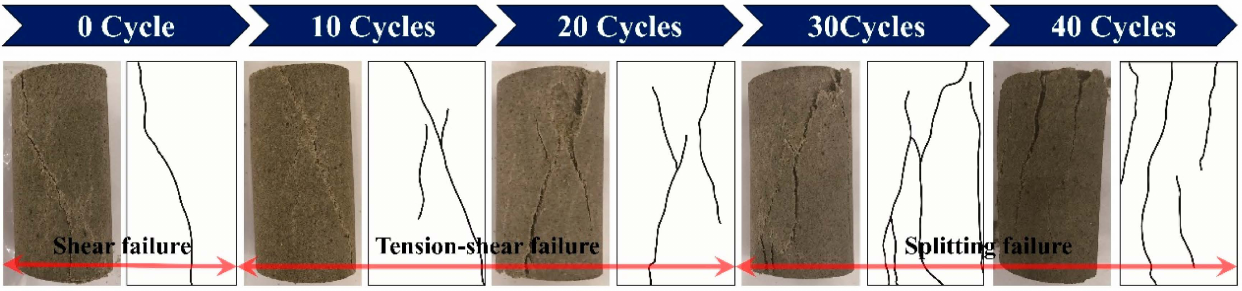
Figure 8. Failure modes of sandstone specimens after undergoing different quantities of F&T weath- ering cycles in uniaxial compression